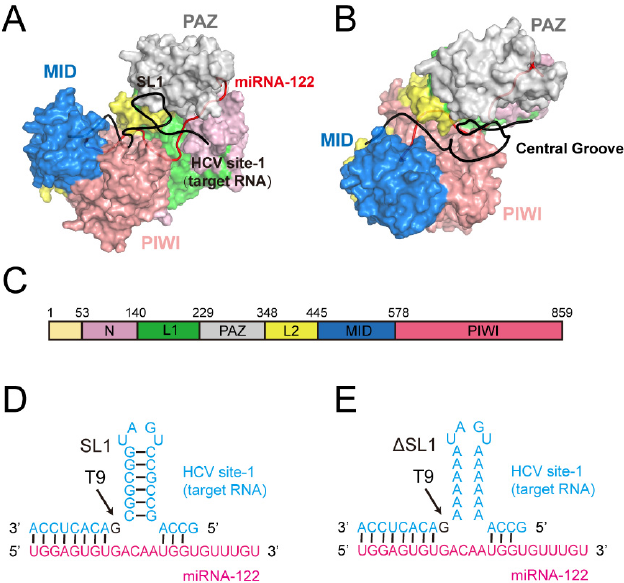
Figure 1. Overview of the Ago2–RNA complex. ( A , B ) Surface representation of the Ago2: miRNA (red): HCV site 1 RNA (black) complex. The SL1 structure and the central groove were noted. ( C ) The domain organization of the Ago2 protein. Nucleotide sequences of miR-122 (magenta) and target RNA (blue) in the WT ( D ) and the Δ SL1 ( E ) system. The T9 (G21) nucleotide (black) is indicated with arrows.